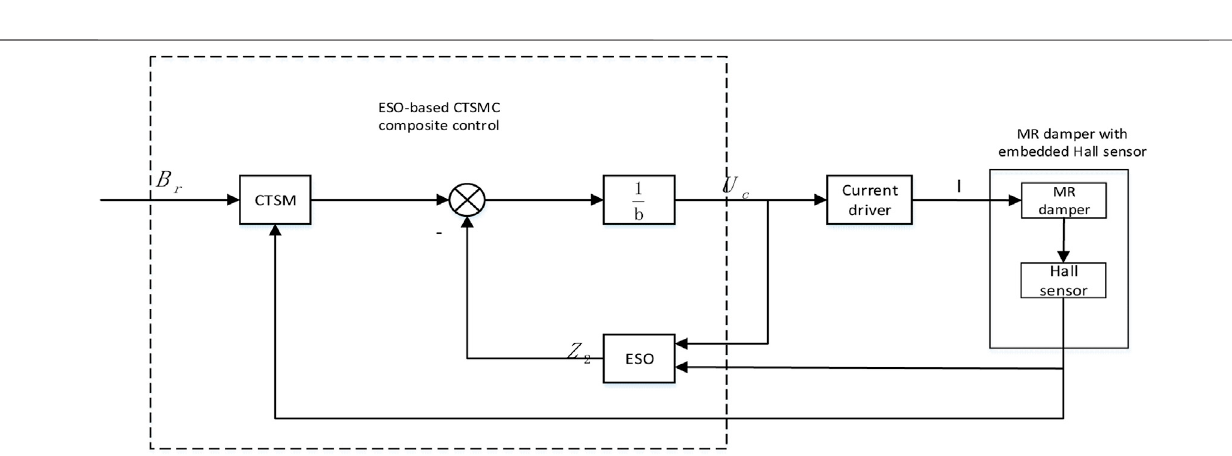
Frontiers in Materials |